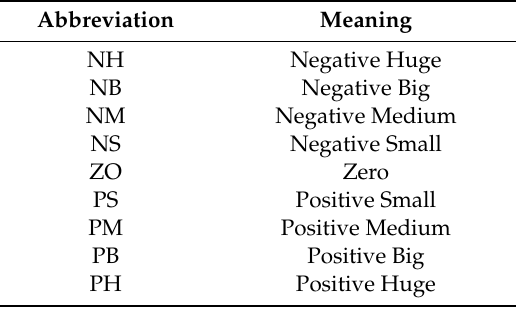
Table 3. Fuzzy membership function.